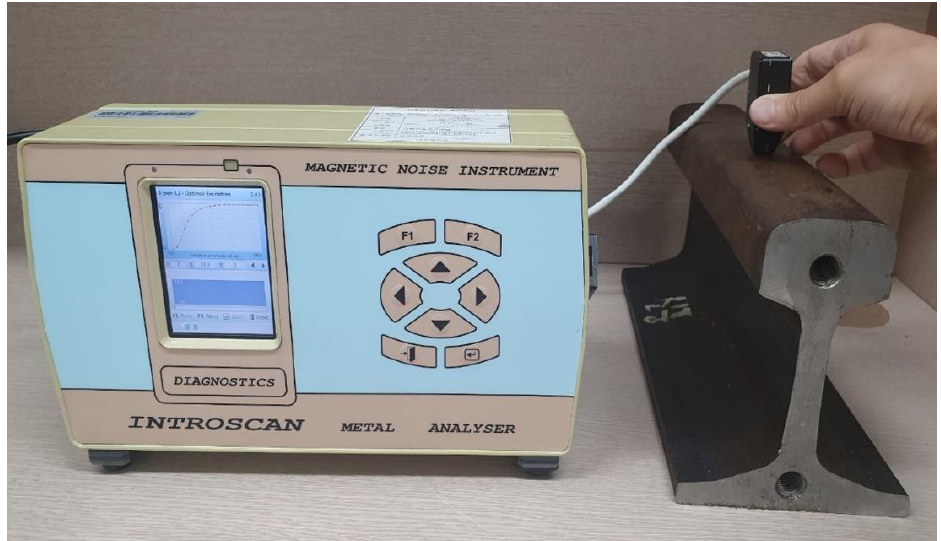
Figure 1. Photograph of the experimental setup for selecting experimental conditions to measure stresses on rails.